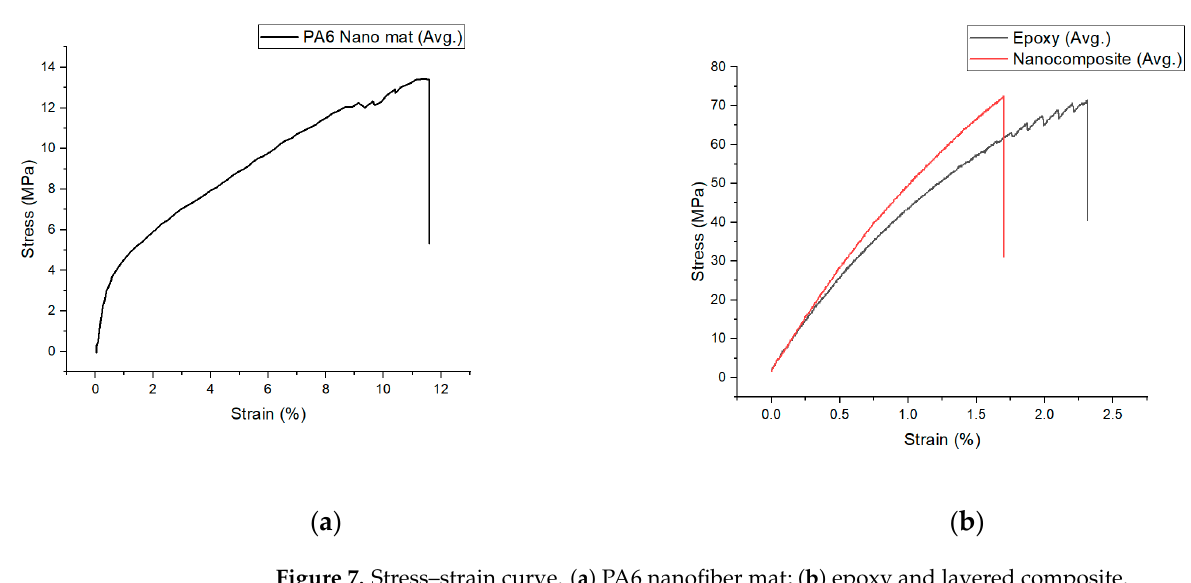
Figure 6. SEM image of the nanocomposite.